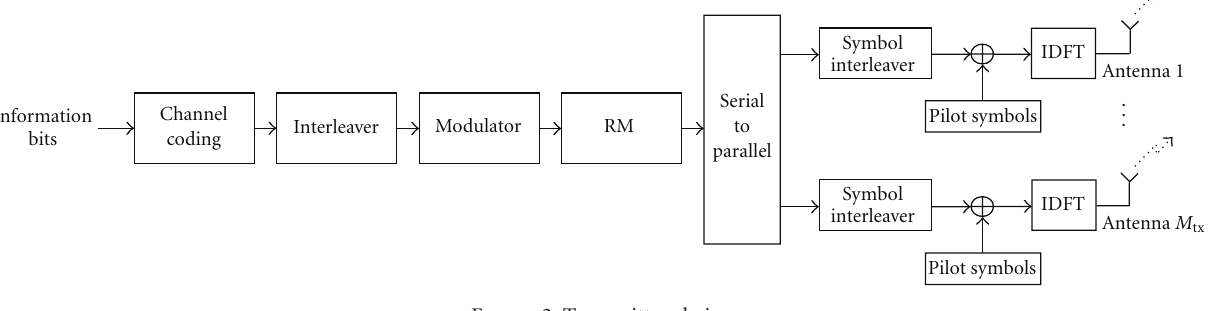
Figure 2: Transmitter chain.